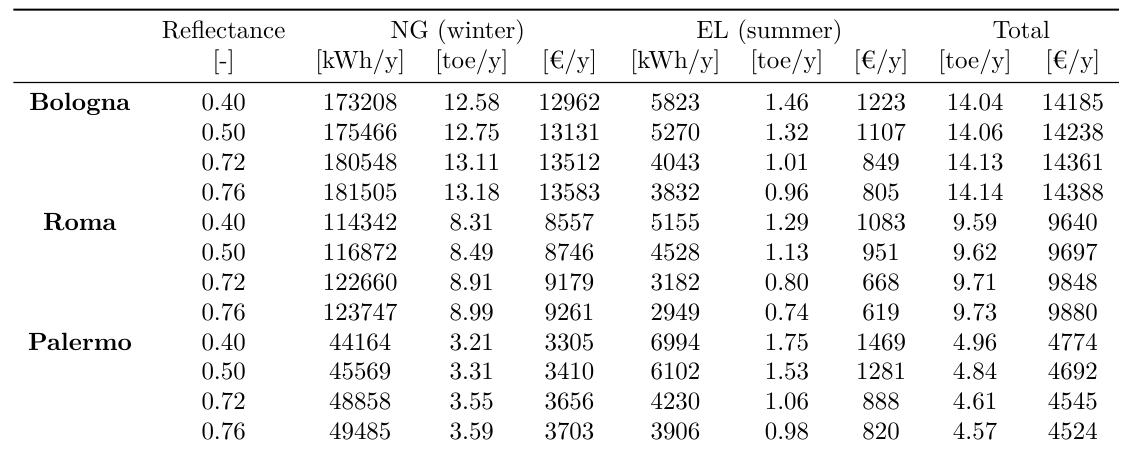
Table 2. Results of simulation: primary energy demand (NG = natural gas; EL = electricity).